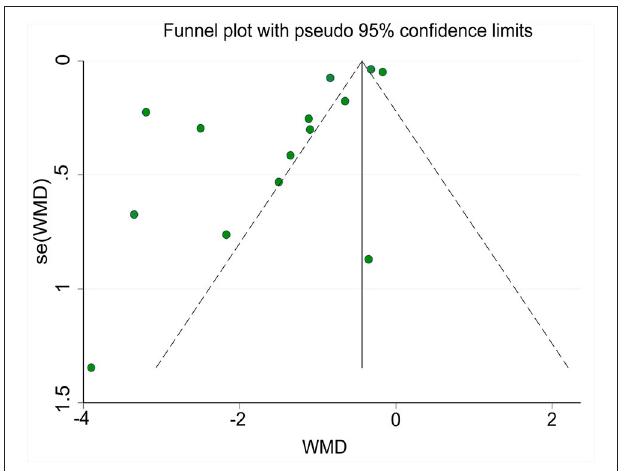
FIGURE 12 | Funnel plot of the time until relief of abdominal